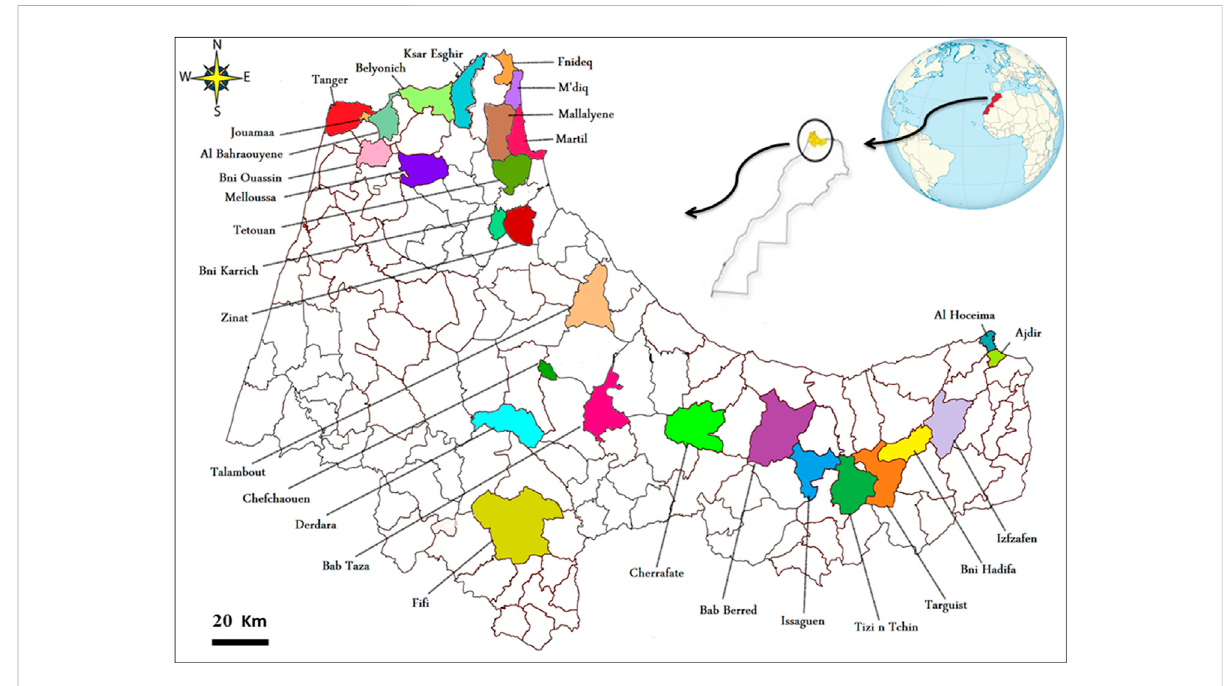
FIGURE 2 Distribution of survey points at the study area